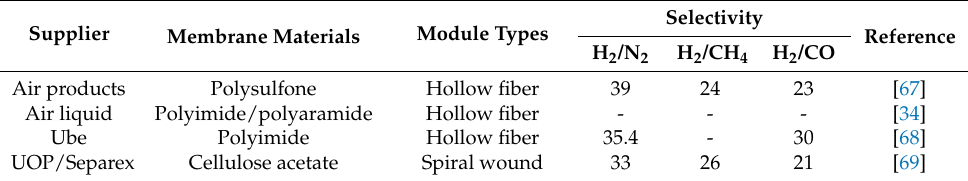
Table 3. Commercial polymeric membranes for hydrogen separation